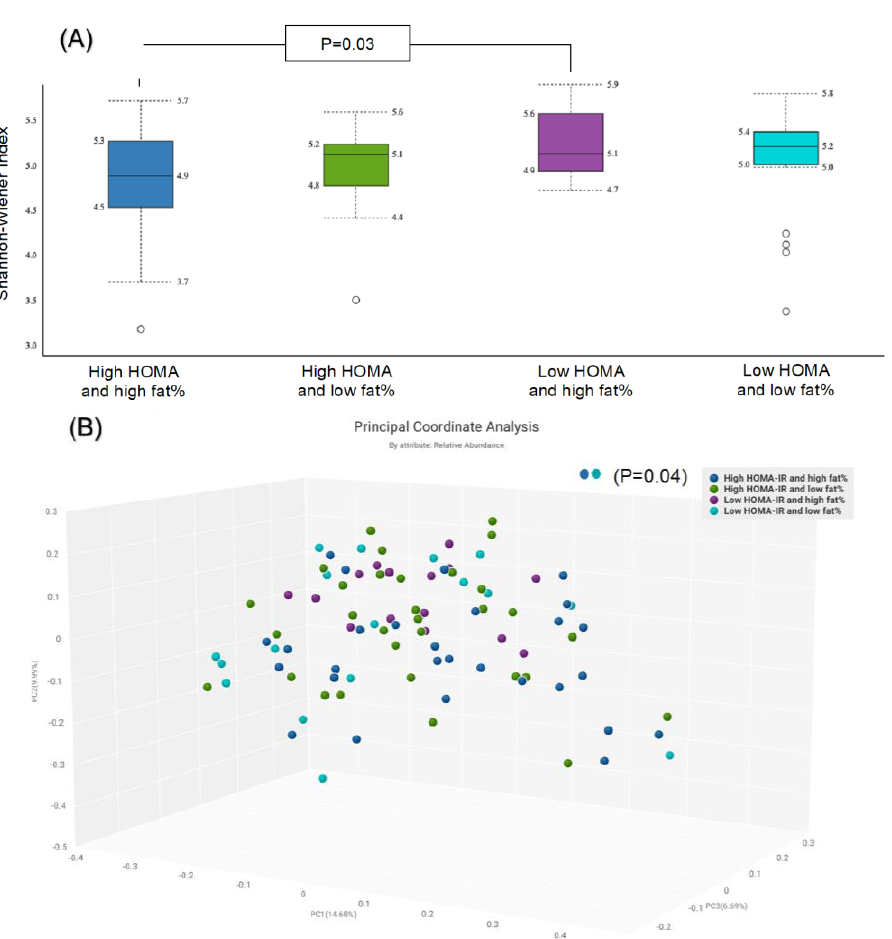
Figure 4. Comparison of bacterial diversities between the gut microbiota of the groups with high HOMA and high fat%, high HOMA and low fat%, low HOMA and high fat% and low HOMA and low fat%: ( A ) α -diversity, ( B ) β